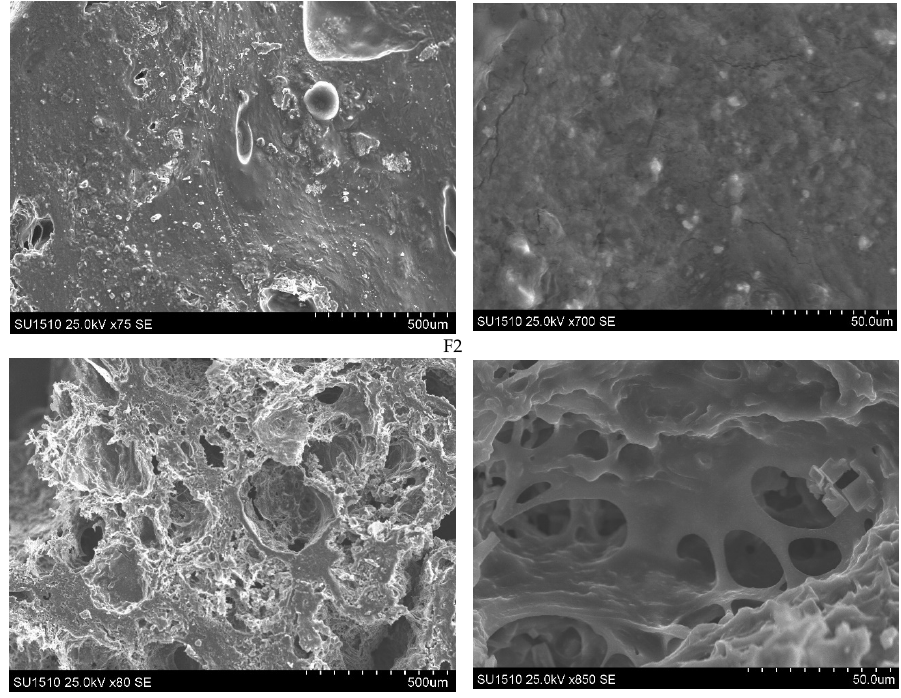
Figure 2. SEM images of the AG/CMC films (samples F2 and